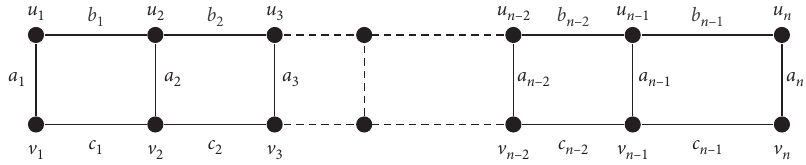
. (b) A 3-edge even labeling of B 9 , 7